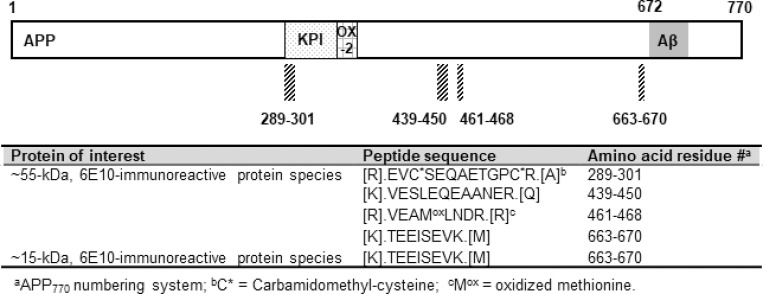
Aβ/APP fragments in the ~55- and the ~15- kDa, 6E10-immunoreactive proteins identified by mass spectrometry.Schematic diagrams showing peptide fragments (striated blocks) in the ~55- or the ~15- kDa species. The sequences of MS-identified peptide fragments are listed in the table below the diagram. KPI = the Kunitz-like protease inhibitor domain, present in the APP770 and APP751 isoforms but absent in the APP695 isoform; OX-2 = the OX-2 antigen domain, present in the APP770 isoform but absent in the APP751 and APP695 isoforms.